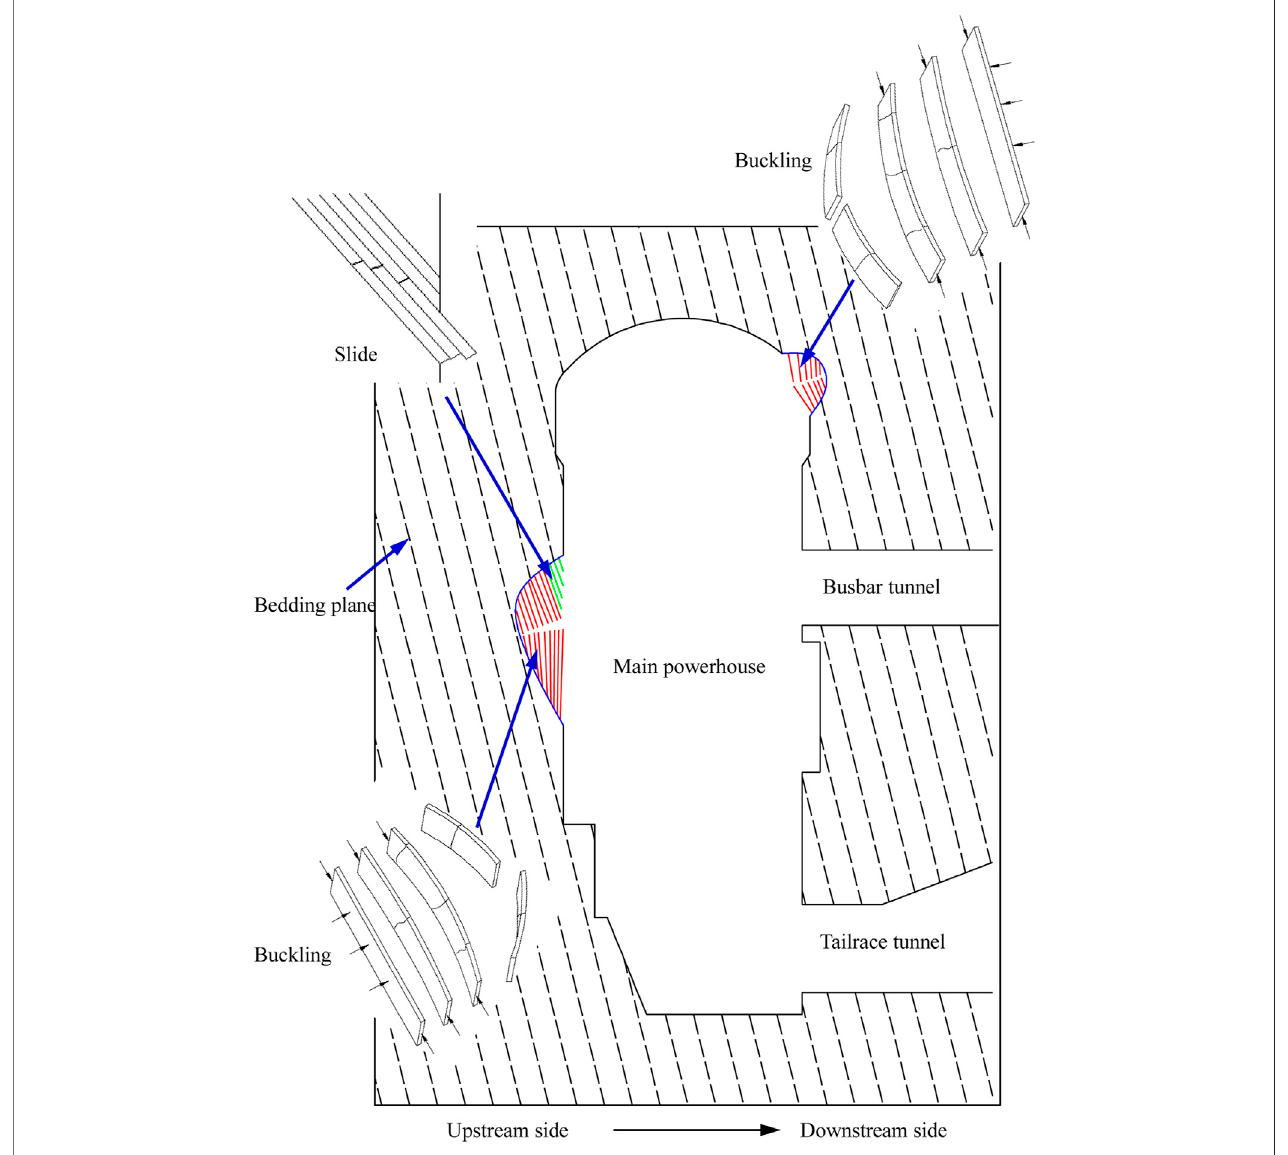
FIGURE 11 | Schematic view of the deformation and failure mechanisms of the steeply inclined small-angle layered rock mass in the right bank powerhouse.